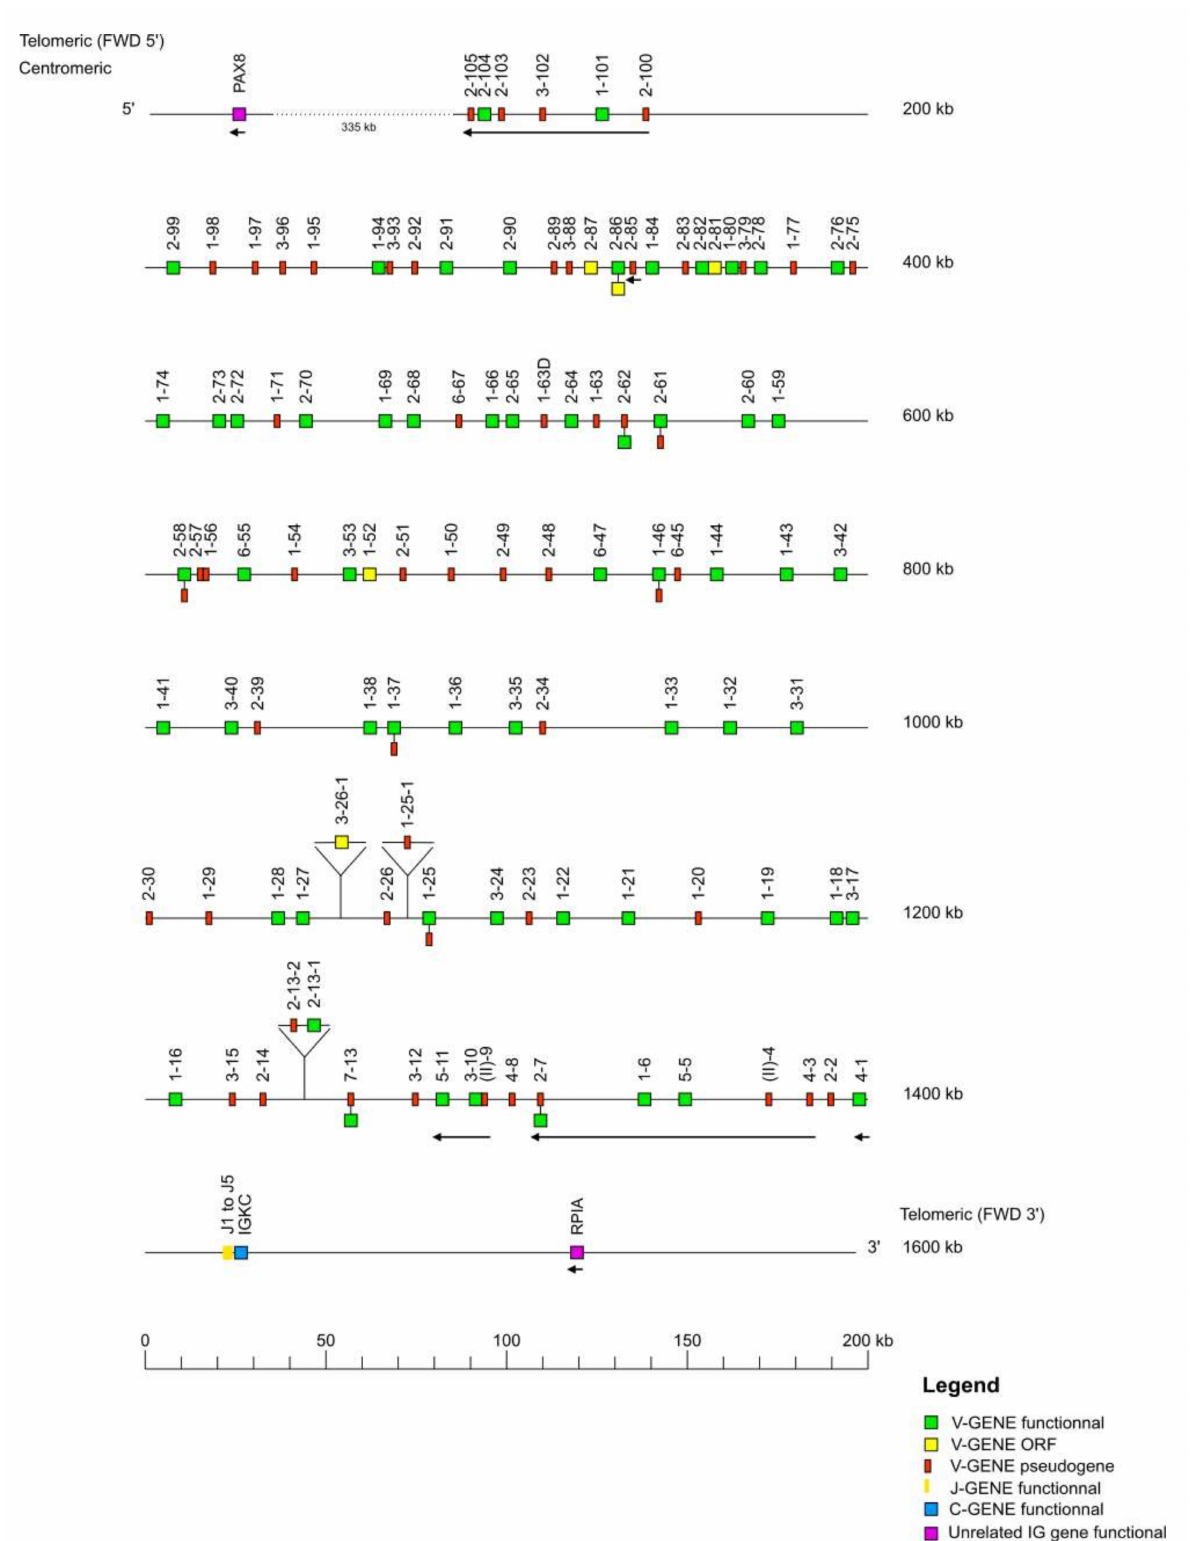
Figure 8. Locus representation of the Macaca mulatta (rhesus monkey) IGK deduced from the genome assembly Mmul_10. Reproduced with permission from IMGT ® , the international ImMunoGeneTics information system ® , http://www.imgt.org (accessed on 11 November 2021). A dotted line . . . indicates the distance in kb between the locus and the IMGT 5 (cid:48) borne. These distances are not represented at scale and are not included in the numbers displayed at the right ends of these two